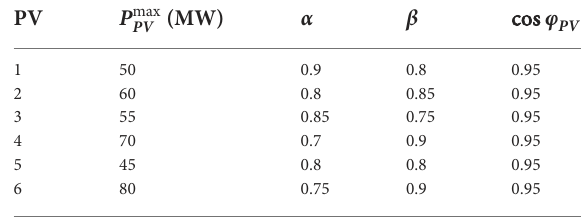
TABLE 3 Parameters of PVs.